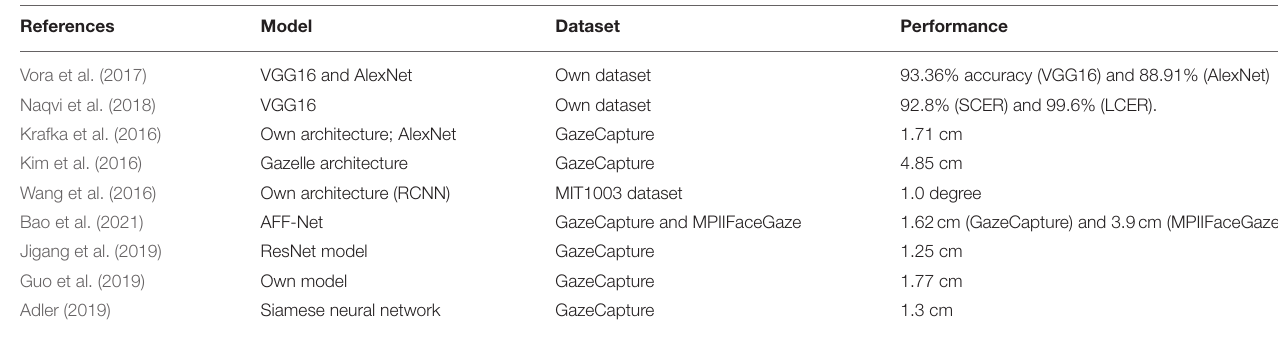
TABLE 1 | Summary of related